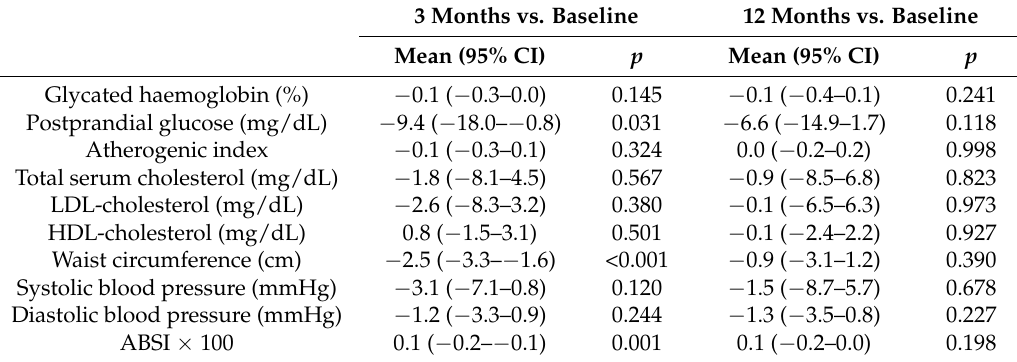
Table 5. Intergroup modifications of the clinical parameters in the follow-up visits compared to the baseline visit. 3 Months vs. Baseline 12 Months vs.